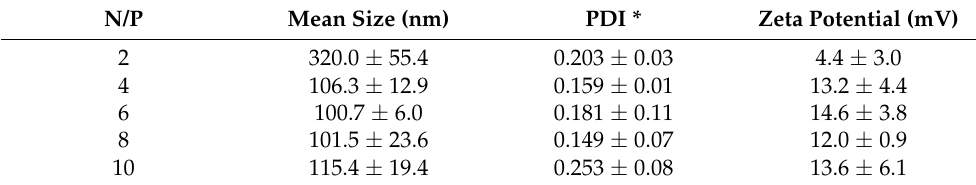
Figure 1. The formation of ternary complexes. A fixed amount of pDNA was incubated with various amounts of cationic polymer and peptide (PEG-PEI:RVG-R9 = 1:1). The ternary complexes were analyzed using agarose gel electrophoresis. Table 1. Size and zeta potential of ternary complexes.